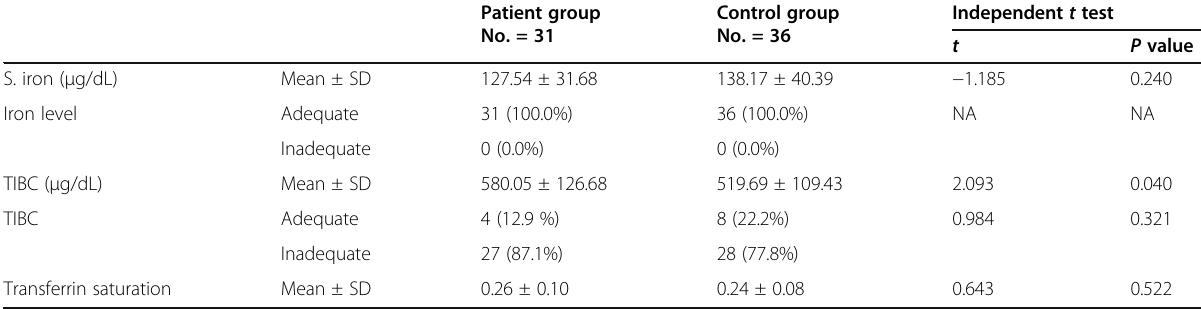
Table 3 Serum iron, TIBC, transferrin saturation, and adequacy of iron level and TIBC compared to normal levels